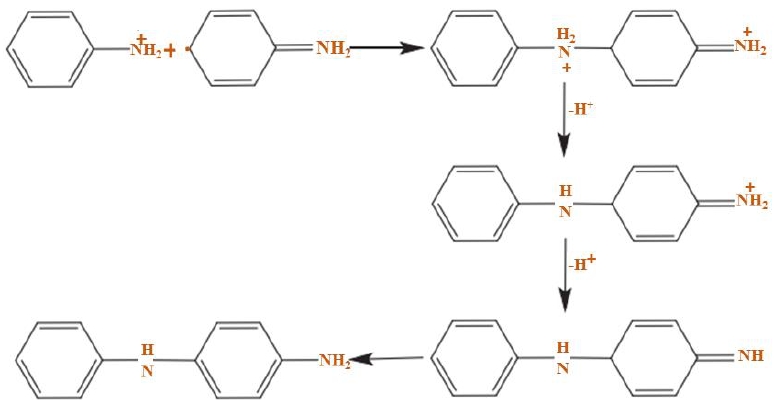
Figure 8. Structure for the dimer. Reproduced with permission from Materials Chemistry and Physics, Vol 69, Koval, E.P.; Whittingham, S.; Skolozdra, O.M.; Zavalij, P.Y.; Zavaliy, I.Y.; Reshetnyak, O.V; Seledets, M. Co-polymers of aniline and nitroanilines. Part I. Mechanism of aniline oxidation polycondensation, pp. 154–162, Copyright (2001), with permission from Elsevier.